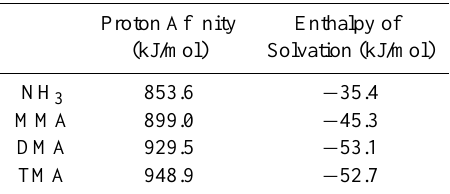
Table 4. Proton affinity and enthalpy of solvation values for NH 3 and the aliphatic amines (Lide, 2010).